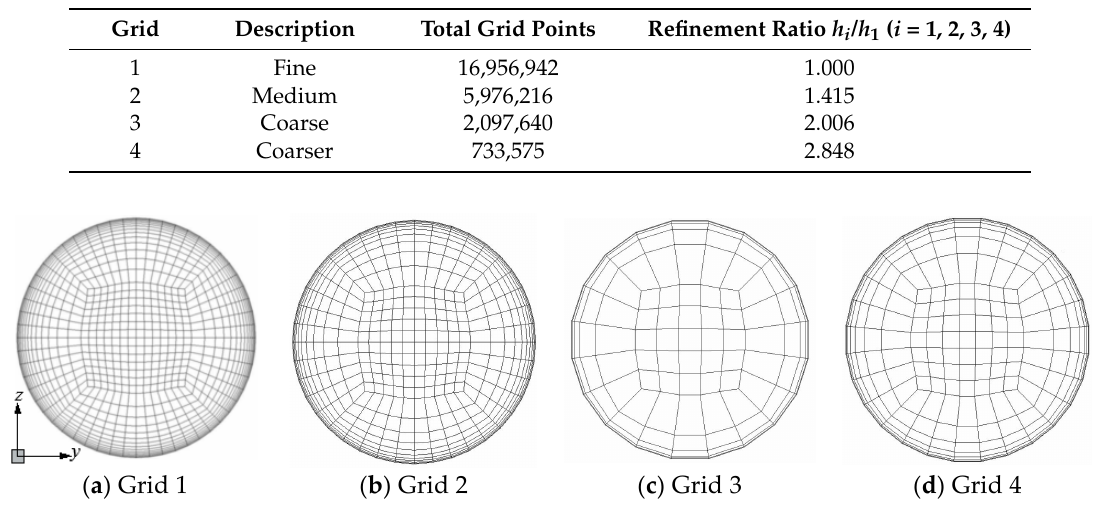
Figure 2. Detail of the grid near the jet nozzle for: ( a ) Grid 1, ( b ) Grid 2, ( c ) Grid 3, and ( d ) Grid 4. Table 2. Dimensions of the grid series.